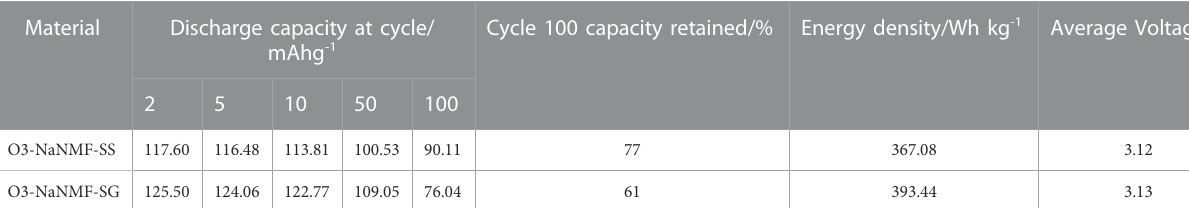
TABLE 2 Tabulated electrochemical performance at C/10.